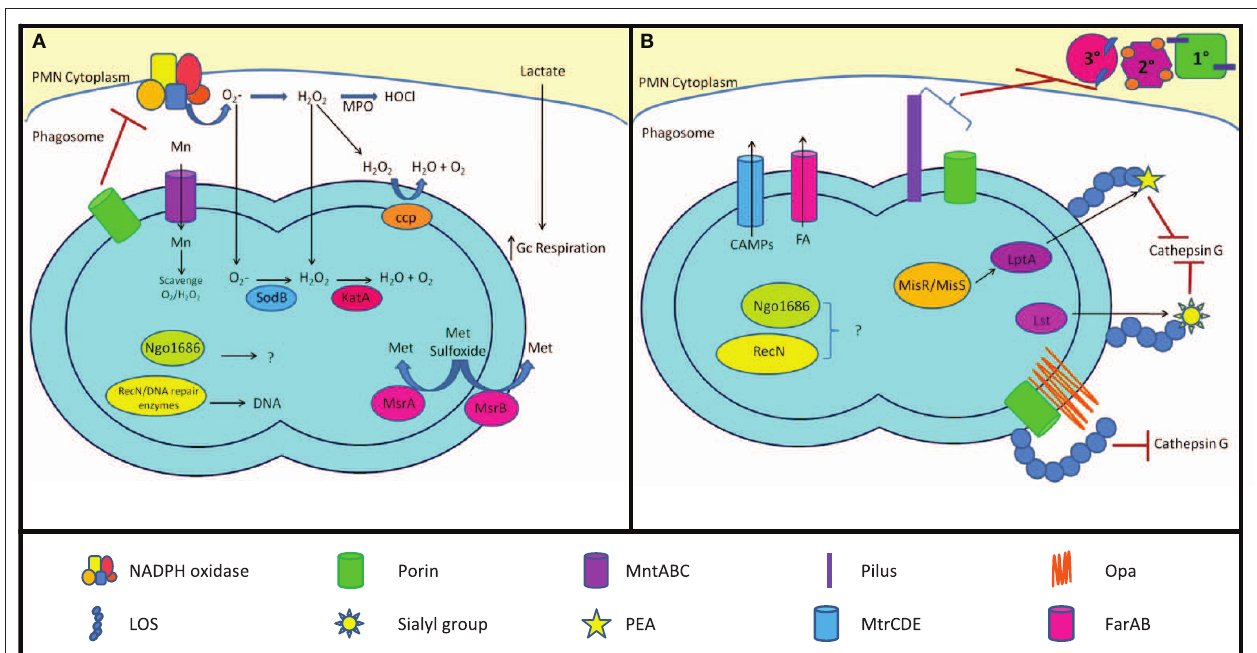
Figure 4 | Mechanisms of gc survival after exposure to antimicrobial granules from releasing non-oxidative antimicrobial components. LOS protects compounds produced by PMNs. (A) Resistance to oxidative damage. PMN Gc outer membrane proteins such as Opa and porin from proteolysis by − ) and hydrogen peroxide (H NADPH oxidase generates superoxide (O O ) from cathepsin G. Sialylation of LOS by Lst and PEA modification of LOS by LptA 2 2 2 O , which are converted to hypochlorous acid (HOCl) by myeloperoxidase increases bacterial resistance to cathepsin G and other antimicrobials. The MisR/ 2 (MPO). Gc prevents PMNs from generating ROS by lactate-mediated increase in MisS two-component regulator increases expression of LptA and other gene Gc O consumption and suppression of NADPH oxidase activity by porin or products that confer resistance to PMN non-oxidative damage. Ngo1686 and 2 as-yet unidentified factors. Gc scavenges ROS through the activities of MntABC, RecN also protect Gc from PMN non-oxidative damage. The MtrCDE and FarAB superoxide dismutase (SodB), catalase (KatA), and cytochrome c peroxidase efflux pumps export cationic antimicrobial peptides (CAMPs) and long-chain fatty (Ccp). Gc can also repair damage due to ROS through DNA repair enzymes acids (FA) from the Gc cytoplasm, respectively. In most cases, the contribution (RecN), protein reductases (MsrA/B), and other proteins (Ngo1686). (B) of these virulence factors to Gc survival after exposure to PMNs remains to Resistance to PMN non-oxidative damage. Gc pili and/or porins prevent PMN